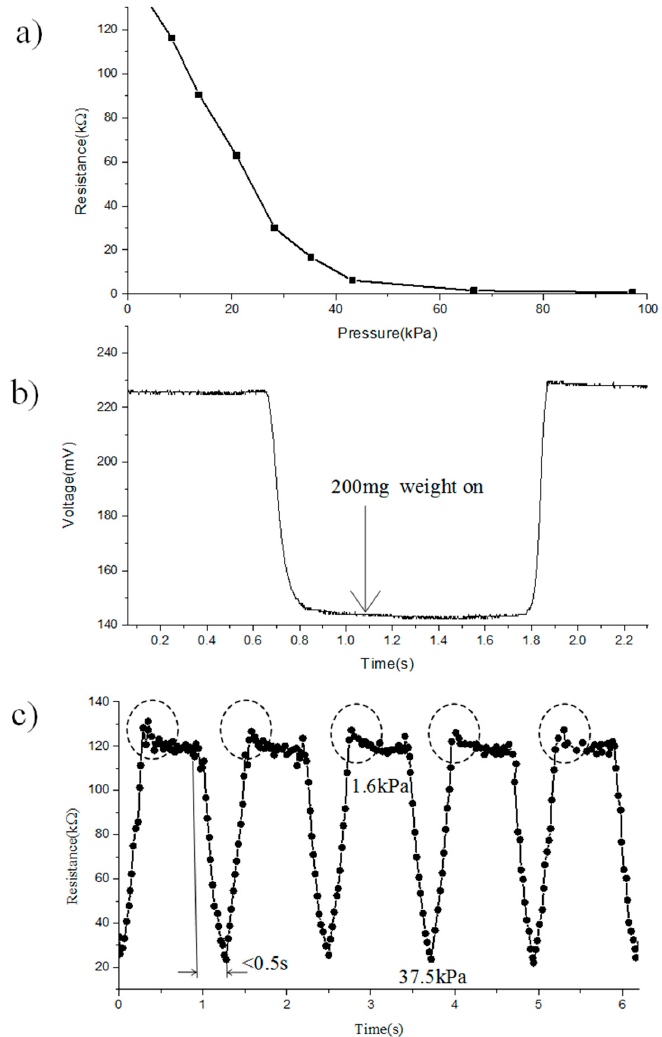
Figure 7. The piezo-resistive characteristic of GCF: ( a ) the relationships between the resistance and applied loading; ( b ) an example of the GCF with the detection of ultralow pressure (200 mg weight on an area of 12.5 mm 2 ); ( c ) stability and repeatability.